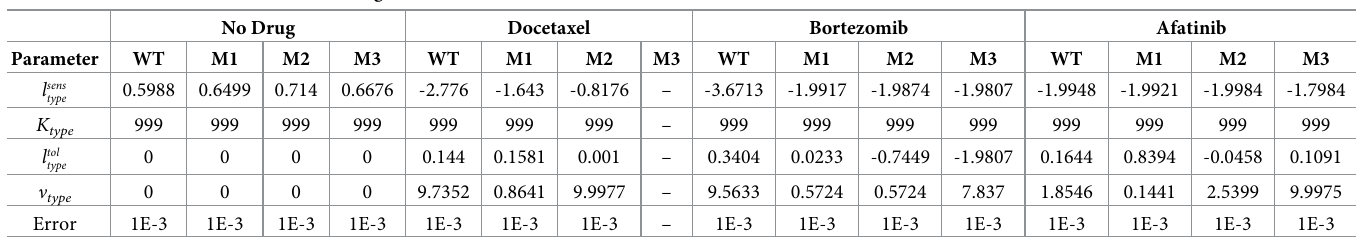
Table 1. Monocultures without and with